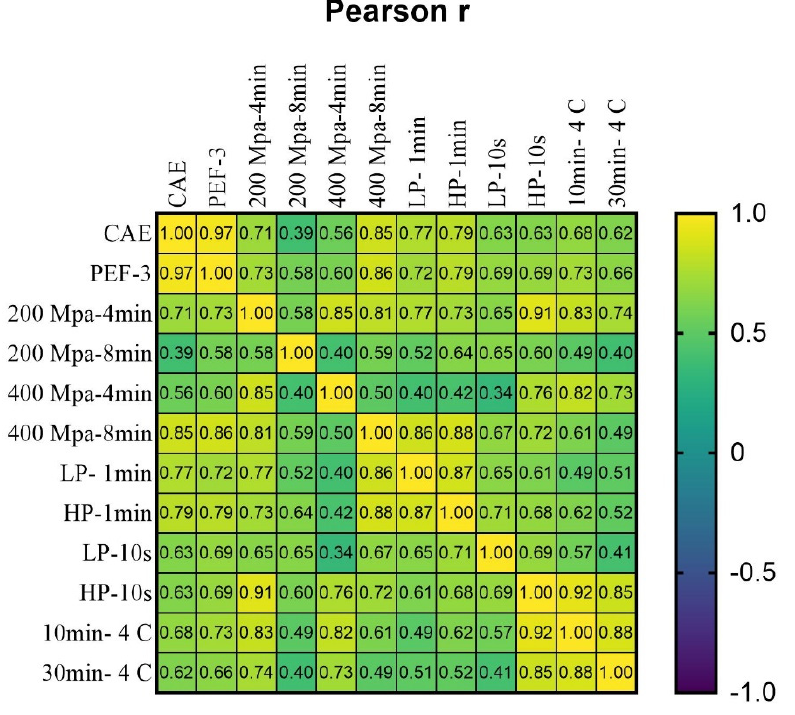
Figure 5. Pearson correlation matrix of several compounds identified in each phenolic group in extracts obtained from buckwheat hull. The sign of the correlations is color-coded (yellow = + and deep blue = − ) and the strength of the correlations (1 to –1) relates to the depth of each color. Abbreviations in the figure are as follows: conventional-assisted extraction-soaking (SO); pulsed electric fields-24 kV-10 KJ-200 Hz-5 µ s (PEF-3) high-pressure processing (200 MPa-4 min, 200 MPa-8 min, 400 MPa-4 min, and 400 MPa-8 min); microwave-assisted extraction (LP-1 min, HP-1 min, LP-10